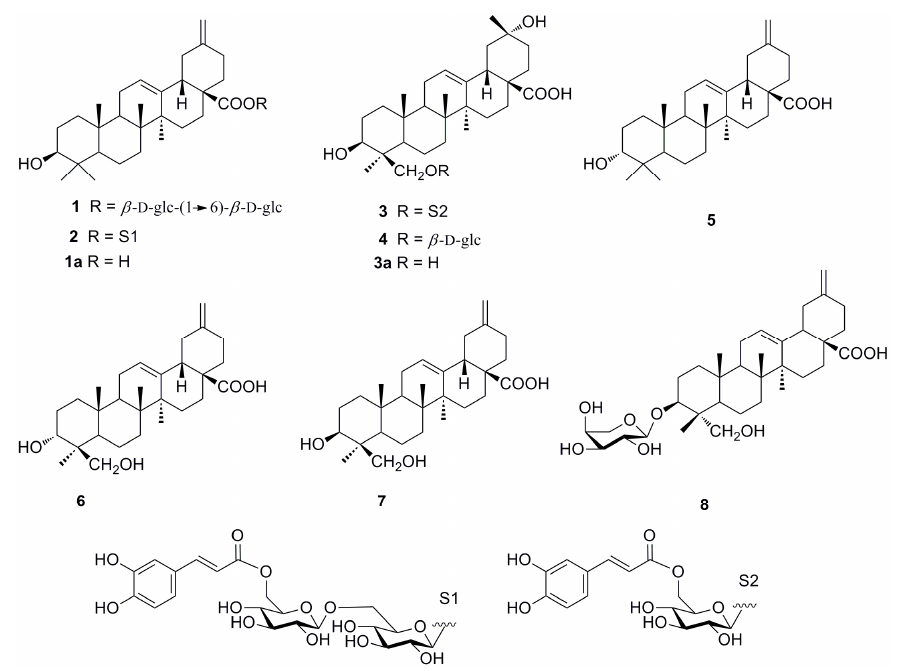
Figure 1. Structures of compounds 1 – 8 isolated from H. coriacea , as well as structures of 1a and 3a mentioned in the text.